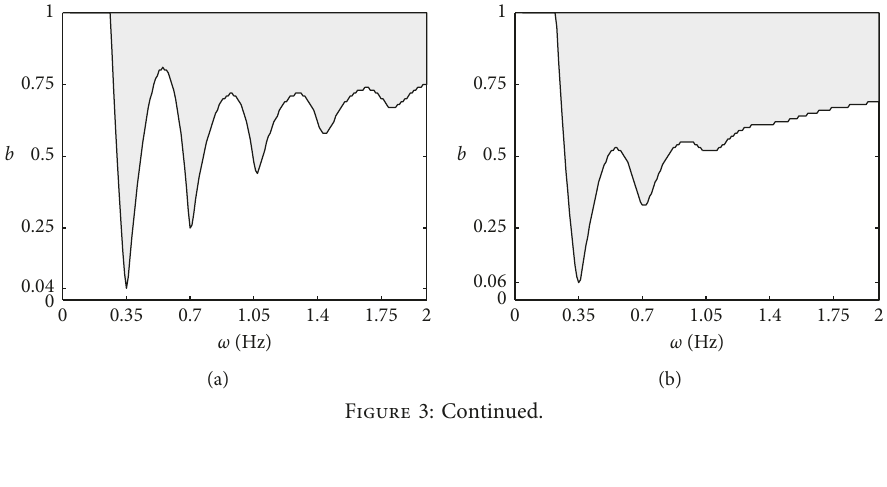
1 . 0 Hz and different values of c : (cid:29) Ω